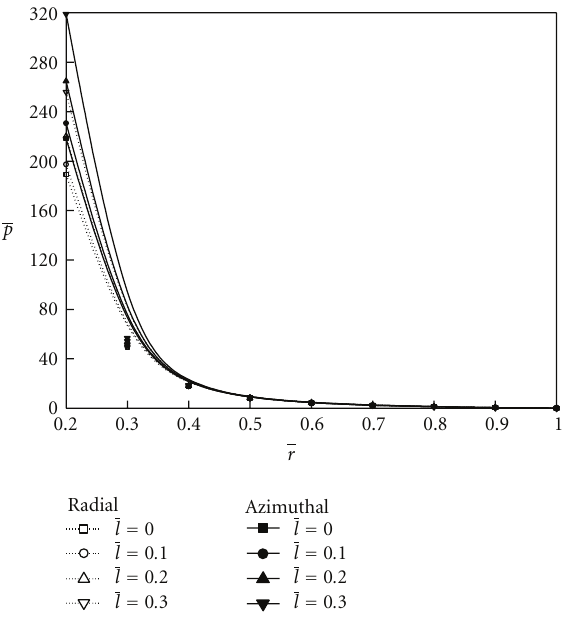
Figure 4: Variation of nondimensional mean film pressure p with r for di ff erent values of c with β = 0 . 05, M = 2, l = 0 . 3, and ψ = 0 .